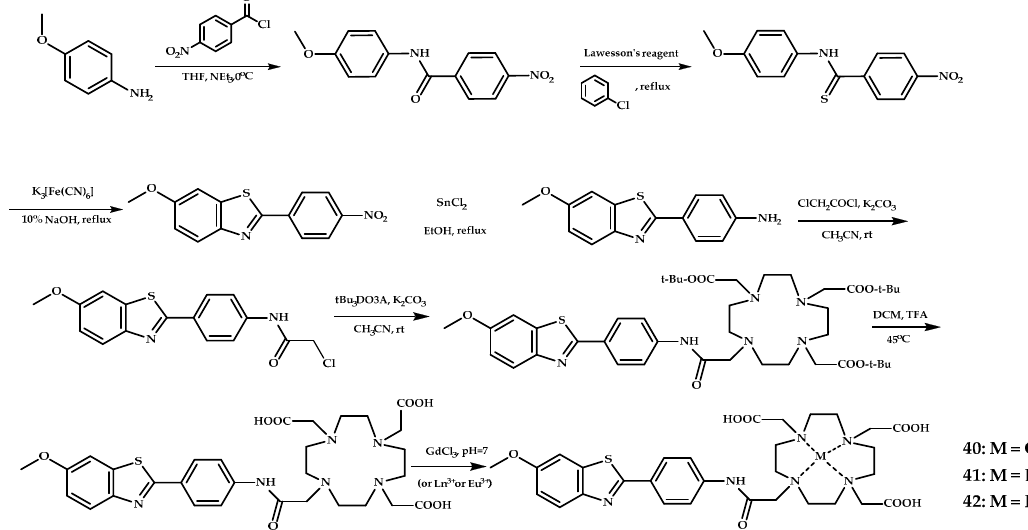
Figure 11. Synthesis of A β -specific DO3A–benzothiazole ligand L40 and coordination compounds 40 (Gd 3+ ), 41 (Eu 3+ ), and 42 (In 3+ ) based on it, designed for MRI and SPECT A β fibrils visualization.